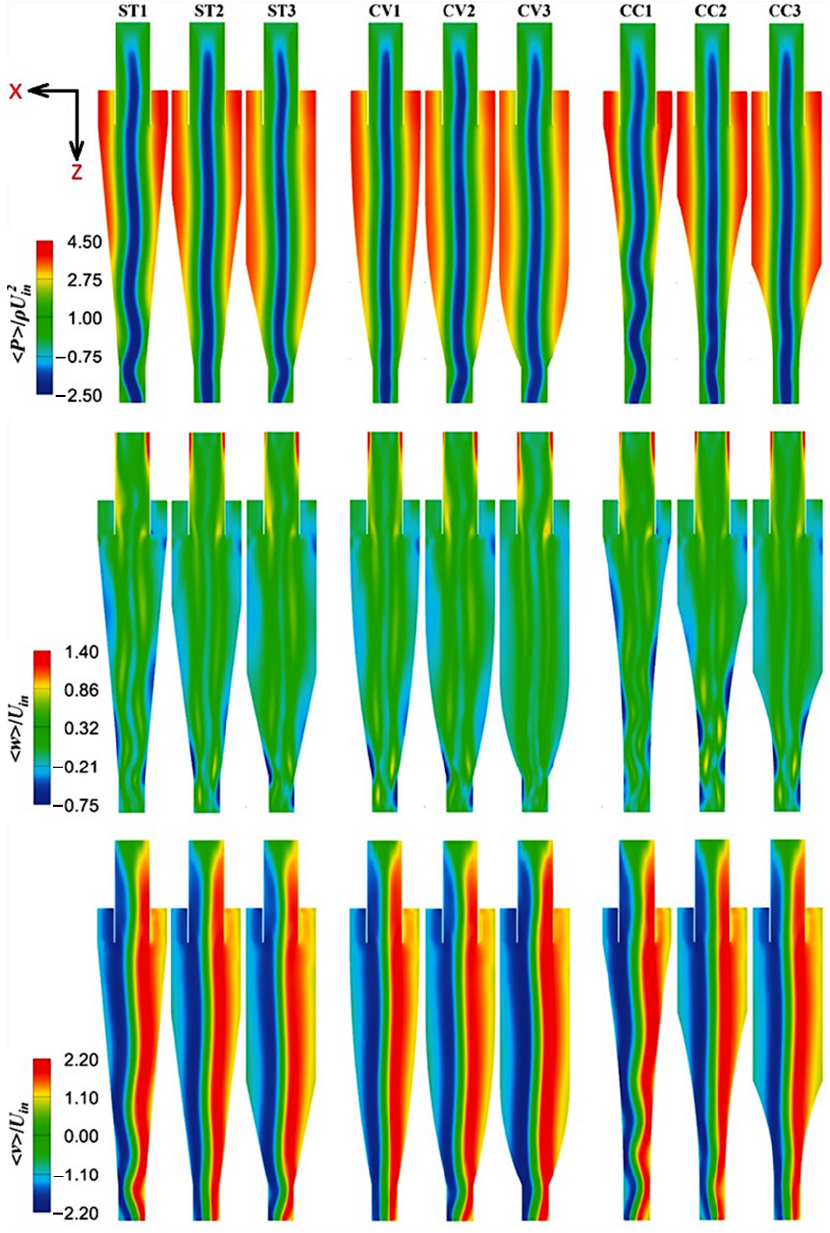
Figure 5. Contour plots on Y / D = 0 plane at U in = 10 m/s. From left to right: different cyclone models. From top to bottom: mean static pressure, mean axial velocity, and mean tangential velocity. The third row in Figure 5 elucidates the contour plots of mean tangential velocity in all models. This is the most important component of velocity as it directly controls the strength of the centrifugal force field generated in cyclones, which in turn influences the collection efficiency and pressure drop. The tangential velocity distribution is nearly the same in all cyclone models, and it is seemingly zero near the geometric axis; thereafter it takes up the maximum value in the core region. More detailed information can be found in the last line of Figure 6 which shows the radial profiles of mean tangential velocity at different axial locations. It becomes apparent that in the core region, the tangential velocity varies linearly—it is zero near the rotational axis of the inner vortex and increases linearly in the core region till it reaches the maximum value. Thereafter, the tangential velocity magnitude decreases rapidly in a nonlinear manner and reduces significantly near the outer walls. The peak value of tangential velocity is maximum in the CC variant and